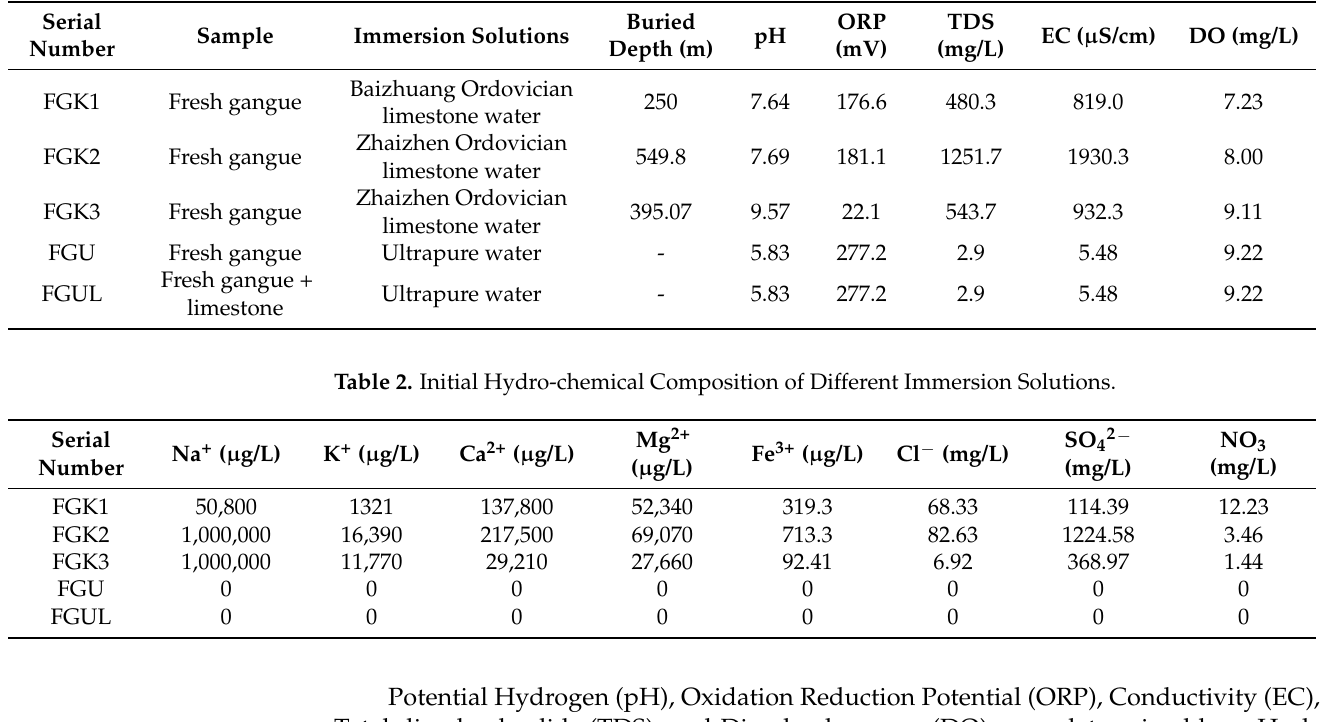
Table 1. Design and Initial Water Quality Parameters of the Coal Gangue Immersion Tests under Different Immersion Solutions.